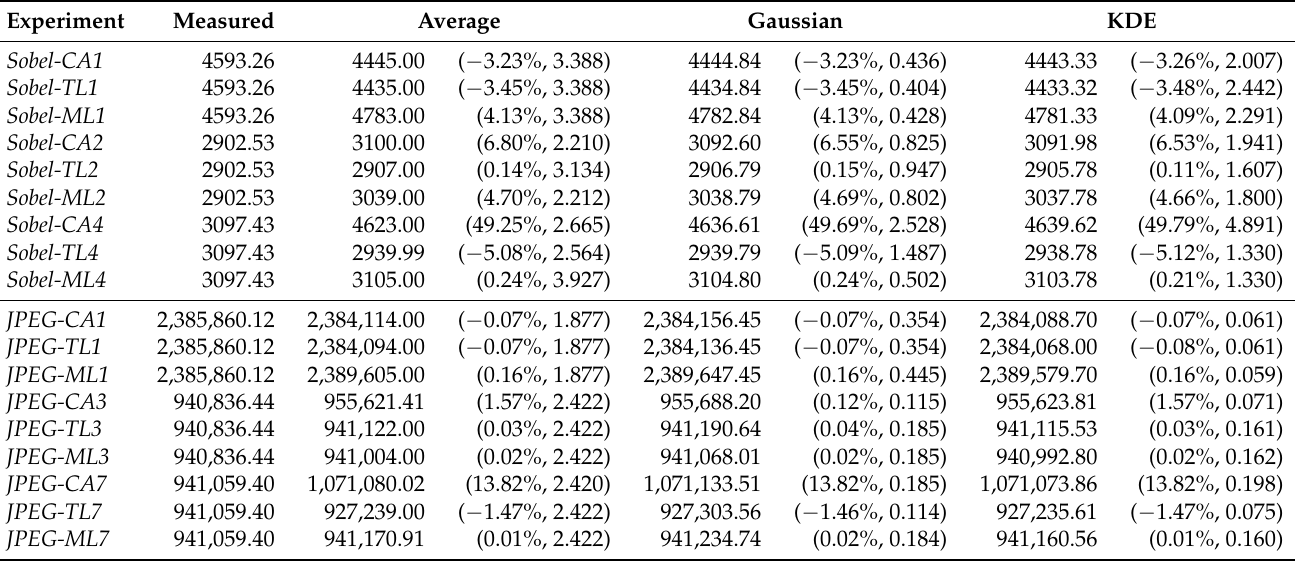
Table 2. Analysis results of the experiments listed in Figure 6. The different communication models (CA, TL, ML) are compared as well as the different computation models (Average, Gaussian Distribution and KDE). 1,000,000 iterations have been measured or simulated. The results are given in clock cycles, errors and Bhattacharyya distance to the observed timing behavior are in